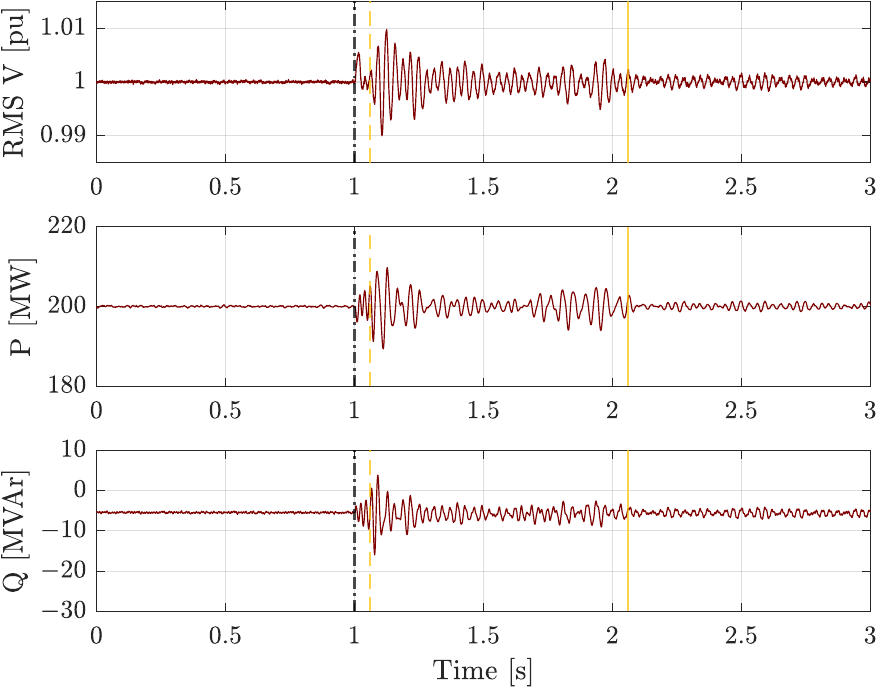
Figure 8. RMS voltage, real power, and reactive power waveforms when output power exceeds 1.025 pu. (black dashed line is when Line #2 trips, yellow dashed line is when SSCI is detected, and yellow straight line is when a stable operating point is